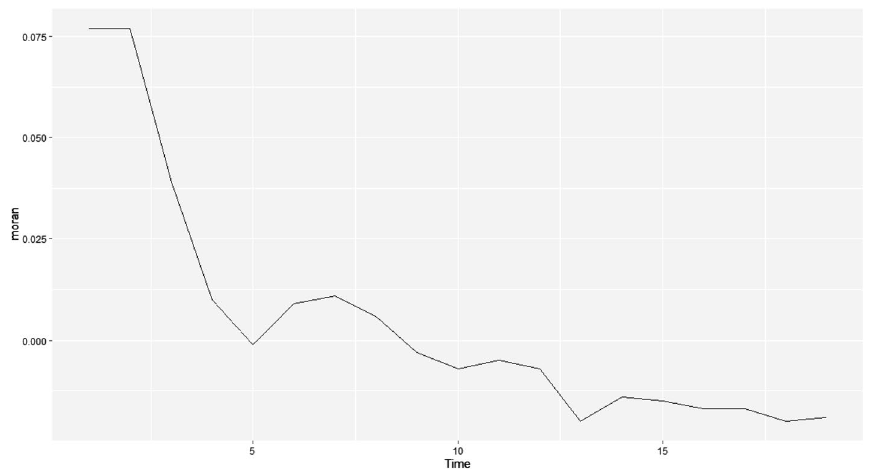
Figure 2. Time-series diagram of spatio-temporal Moran’s I index changes.